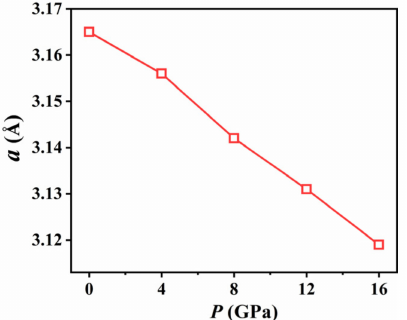
Figure 4. Lattice constants of the single-crystal tungsten at different